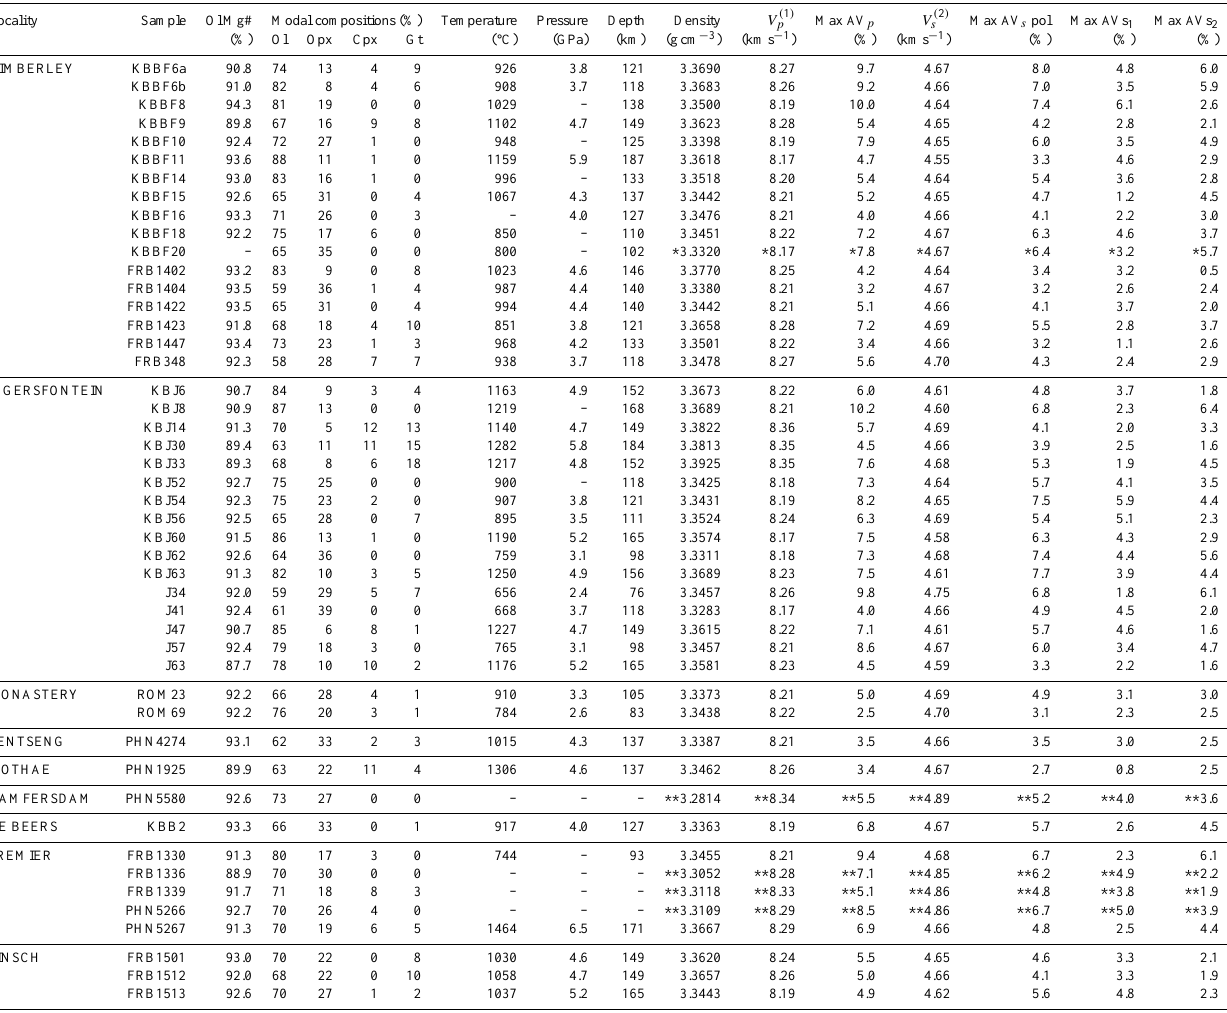
Table 1. Olivine Mg#, modal contents, equilibration conditions, calculated seismic properties and densities of the studied Kaapvaal peri- dotites.